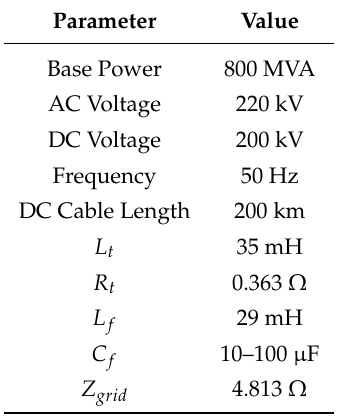
Table A1. Grid data for system